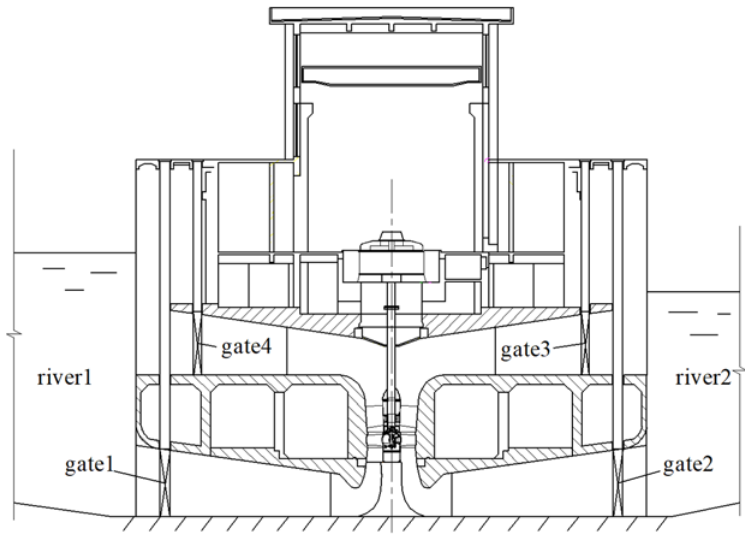
Figure 1. Profile of the pumping station. Table 1. Main parameters and operating conditions of the pumping station.